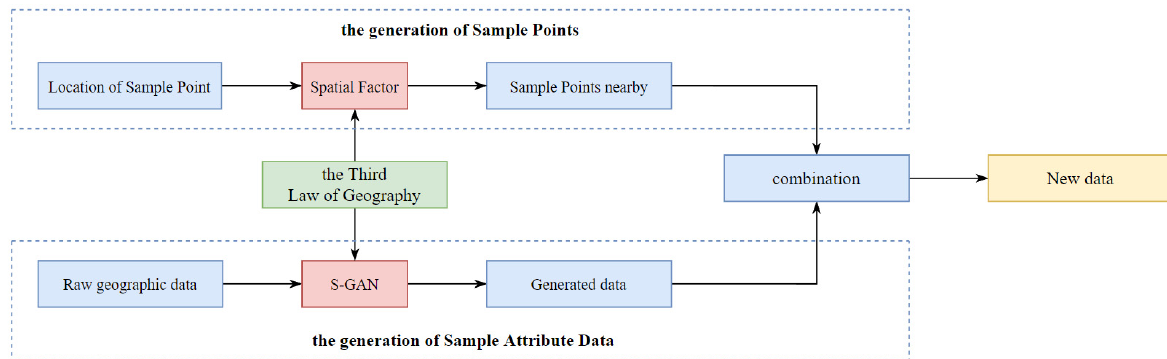
Figure 2. The basic idea of geographic data